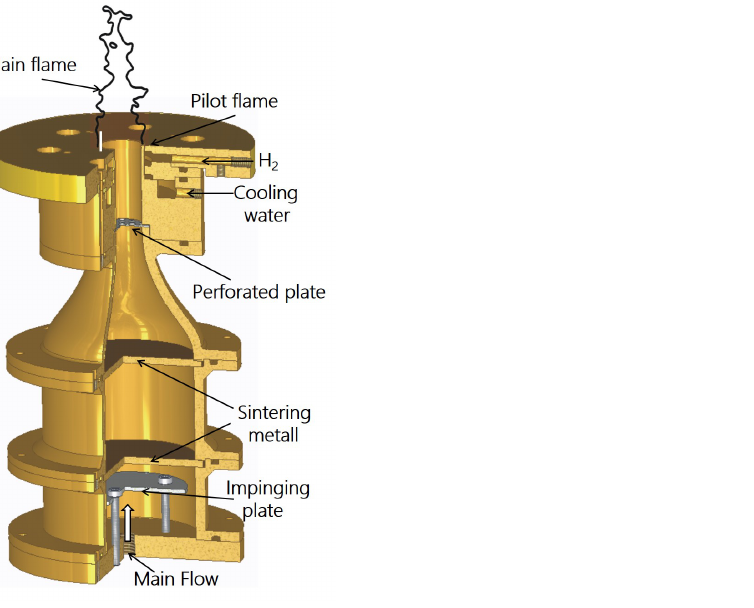
Figure 1. The sketch of the premixed turbulent Bunsen burner.